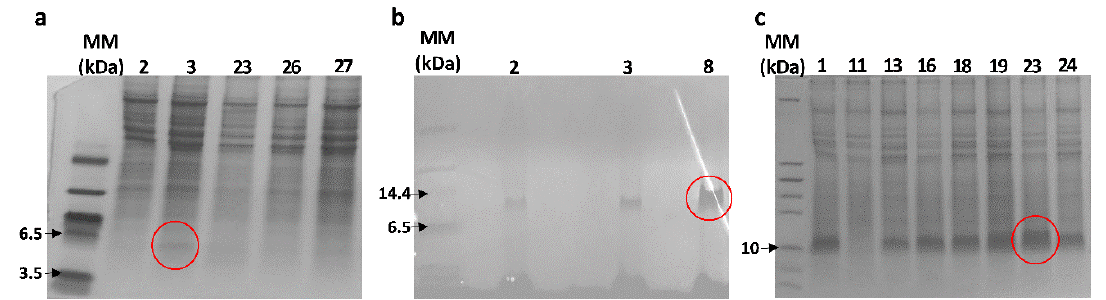
Figure 2. Tricine SDS-PAGE analysis of the different clones expressing the recombinant peptides. MM: molecular marker (kDa). The figure shows the 16% tricine SDS-PAGE analysis of the expression of recombinant Vm24 ( a ), AnTx ( b ), and Ts6 ( c ) by the clones growing at 2000 µg/mL zeocin (numbers above the lines refer to the clone numbers). The red circle indicates the selected clones that showed the highest protein